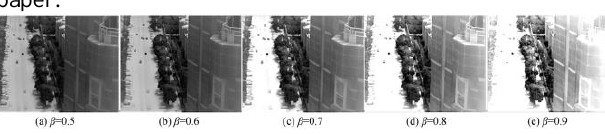
Figure 6. Image fusion result with different β .